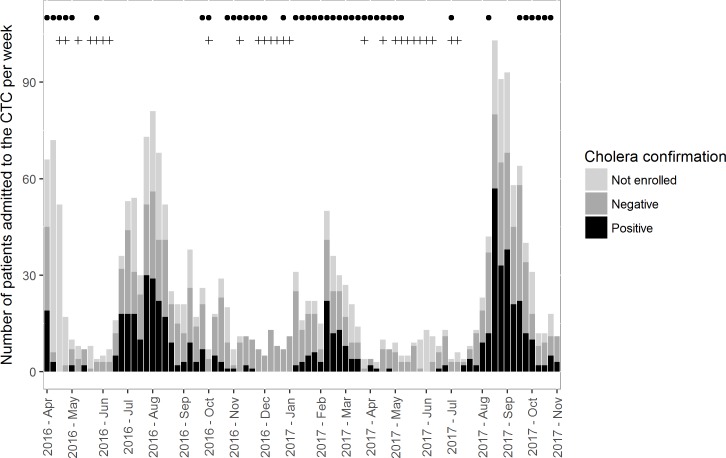
Weekly number of patients admitted to the CTC during the study period.The dots represent weeks classified as “rainy” (weekly rainfall estimated to be above 3.6 mm). The plus signs represent weeks with no cholera confirmed cases.